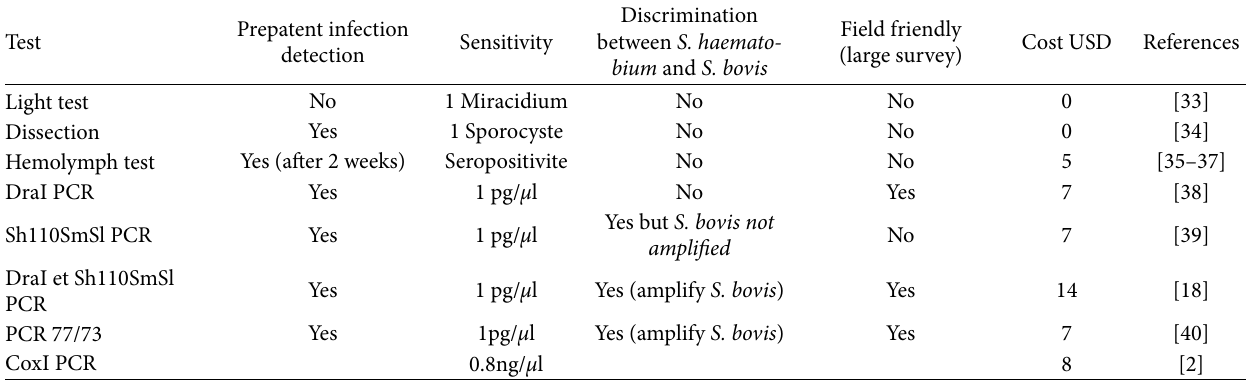
Table 2: Considered tests for malacological diagnosis of S. haematobium